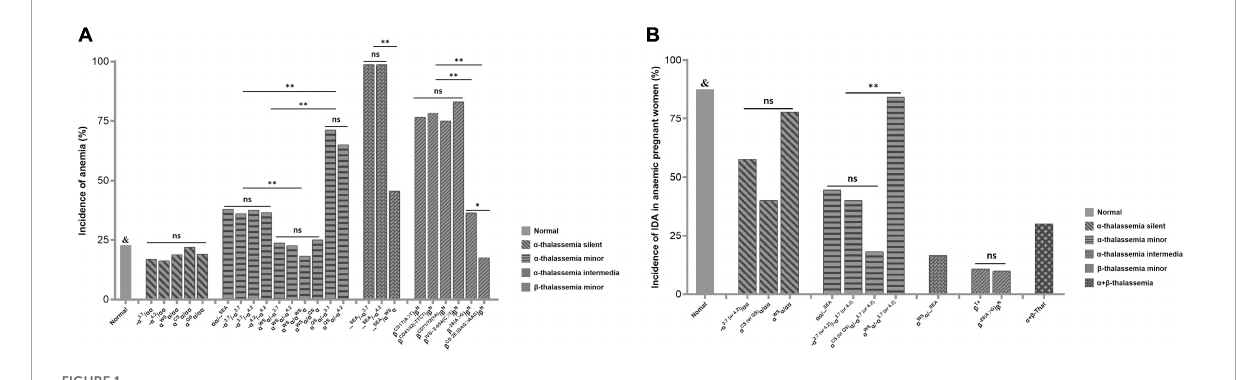
FIGURE1 (A) The prevalence of anemia among PW with various genotypes of thalassemia & P < 0.05 vs. groups of – α 3 . 7 / αα , – α 4 . 2 / αα , αα /– SEA , – α 3 . 7 /– α 3 . 7 , – α 3 . 7 /– α 4 . 2 , – α 4 . 2 /– α 4 . 2 , α QS α /– 3 . 7 , α QS α /– 4 . 2 , – α 3 . 7 /– SEA , – α 4 . 2 /– SEA , α WS α /– SEA , β IVS - II - 654 ( C > T ) / β , β CD41 / 42 ( - TTCT ) / β , β CD17 ( A > T ) / β , β CD71 / 72 ( + A ) / β , and β - 28 ( A > G ) / β . ns, no significant; PW, pregnant women. ∗ P < 0.05; ∗∗ P < 0.01. (B) The incidence of IDA in